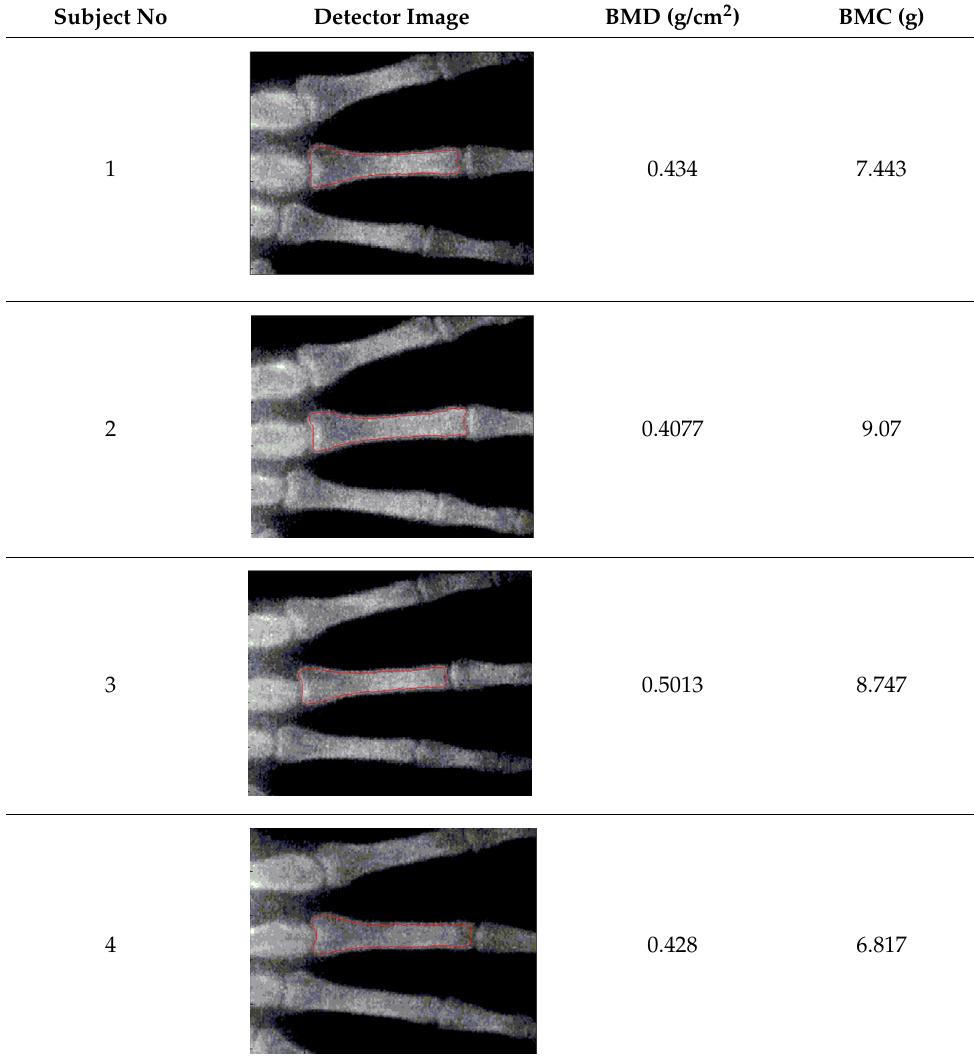
Table 4. Result of bone mineral density and bone mineral content in 6 subjects.